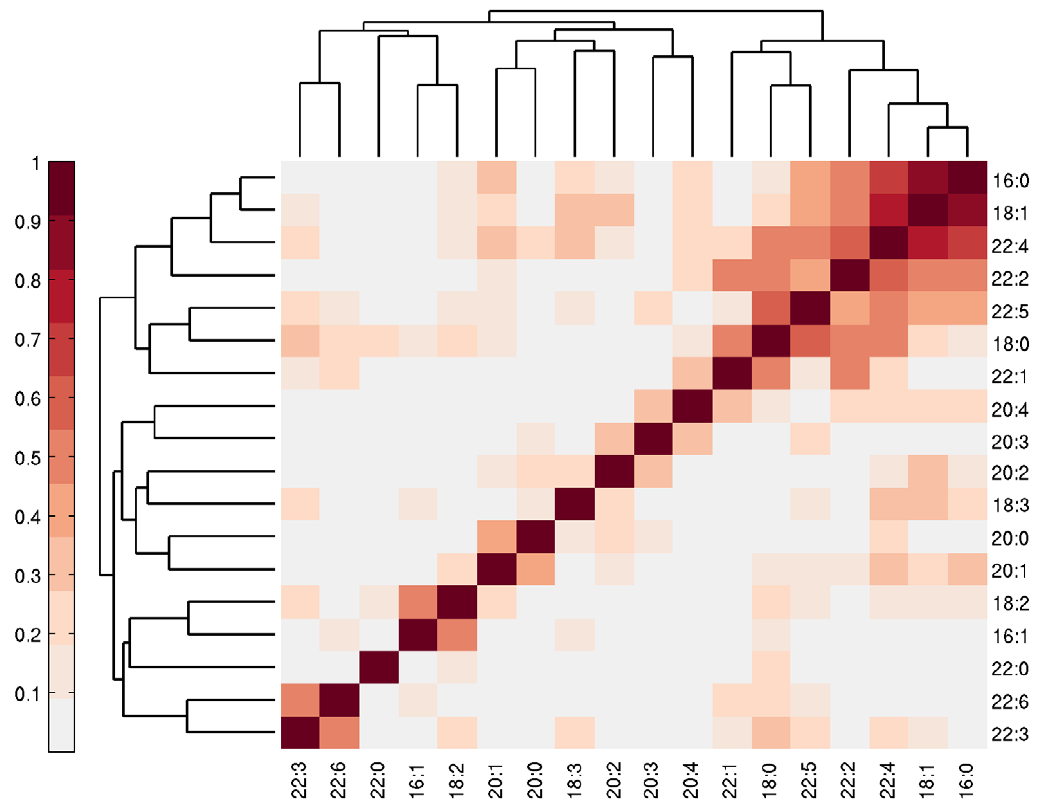
Figure 4. Hierarchical clustering of FAs suggests co-regulation. For each pair of FAs, we calculated the squared correlation of their residuals (data vs. proportional incorporation model) in the 14 brain samples. FAs were then hierarchically clustered. The chains {16:0, 18:1, 22:4} show stronger clustering, suggesting they may respond to the same remodeling enzyme.